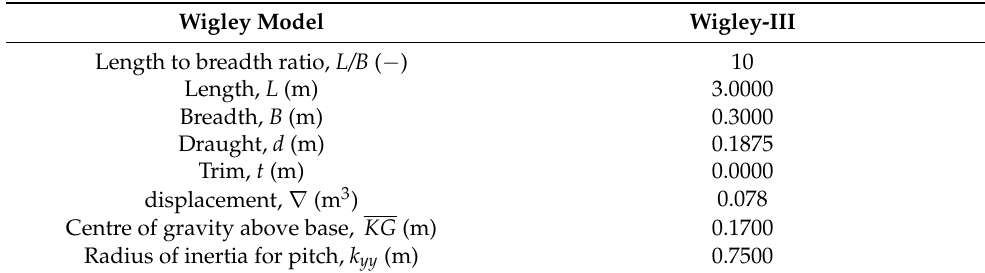
Table 2. Characteristic dimensions of the Wigley